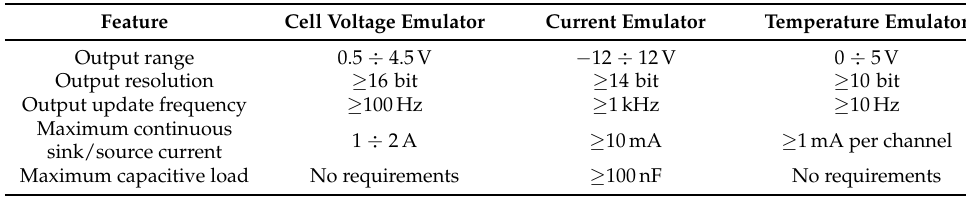
Table 2. Design constraints of the three